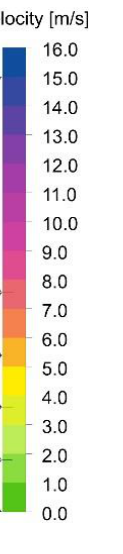
Figure 11. Wind velocity contour in the skygarden at occupants’ height.